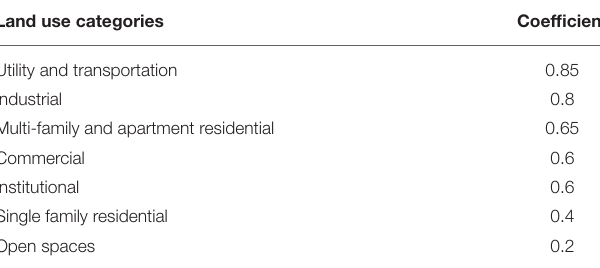
TABLE 3 | The run-off coefficients (Thompson, 2006; Li et al.,